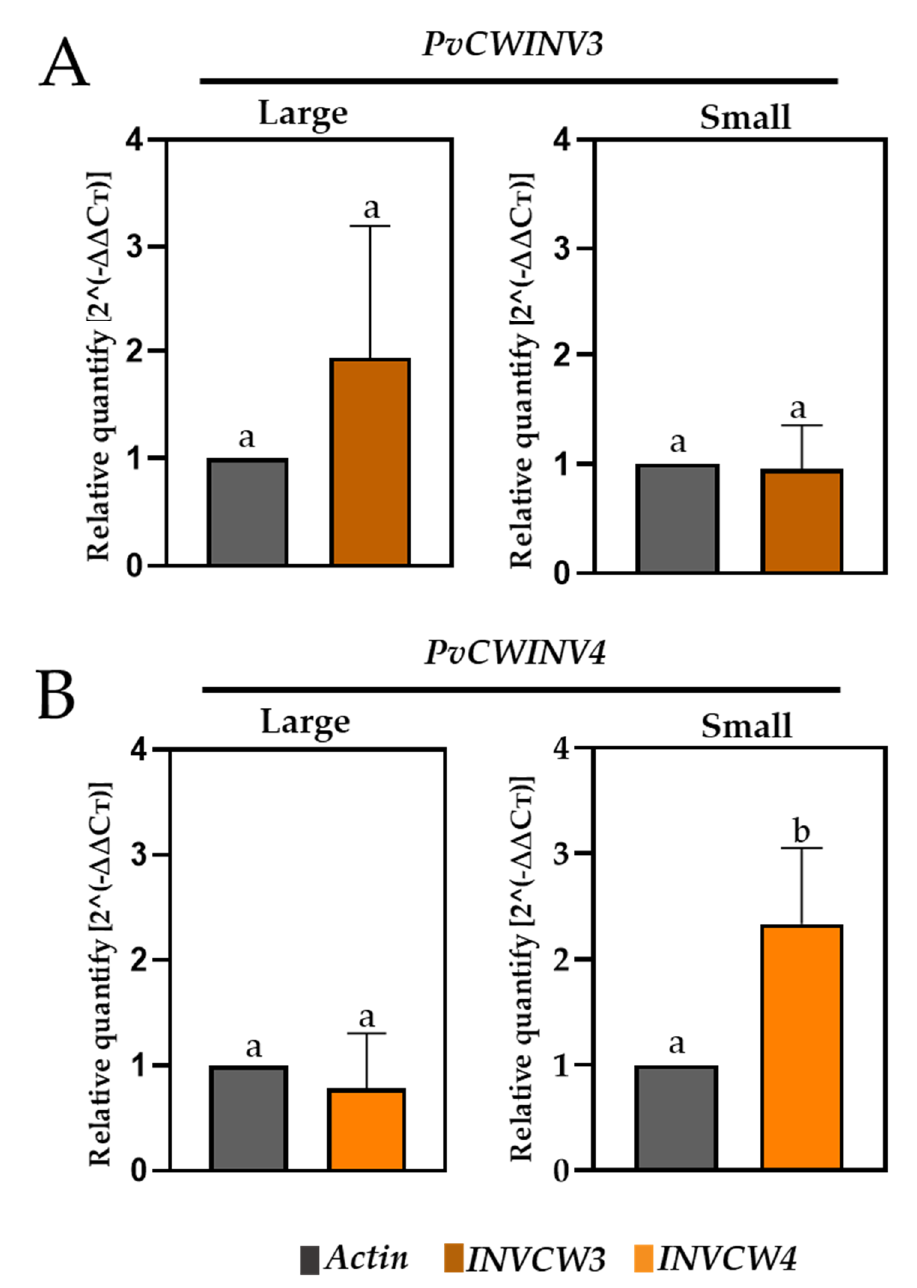
Figure 7. Profiles of qRT–PCR expression ± SE of the Phaseolus vulgaris invertase genes ( A ) PvINVCW3 and ( B ) PvINVCW4 in tissues of large and small pods and developmental stages at 100% FC (field capacity) and after 10 d at 50% FC. The pod sets were harvested at noon (12:00 pm), n = 3. The same letters on bars indicate similarity between treatments (Student’s t test, p < 0.05).